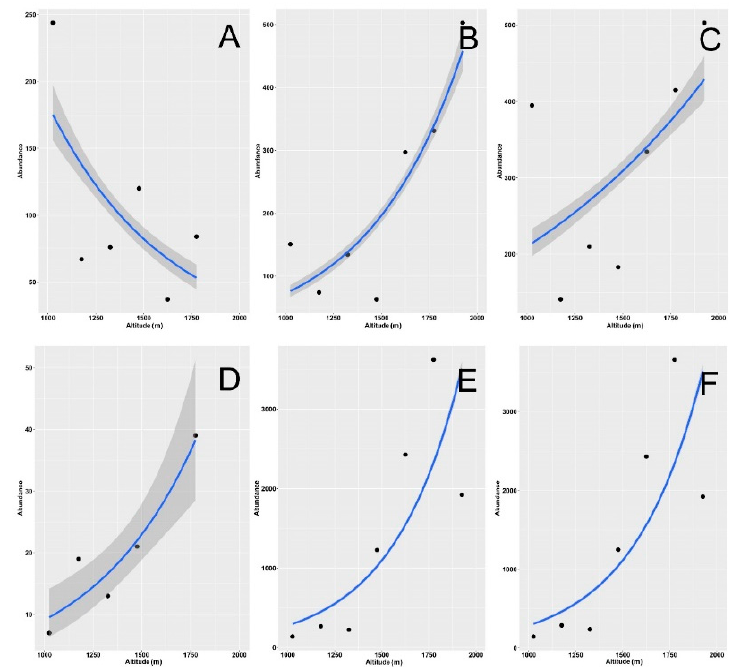
Figure 7. Relationship between dung beetle species abundance and altitude along an elevational gradient in central Italy. Curves were constructed separately for aphodiids ( A – C ) and scarabaeids ( D – F ) using standardized abundance values for the two habitats separately (woodlands: A , D and grasslands: B , E ) and merged ( C , F ). General linear models were used for fitting. Dashed areas are 95% confidence intervals. Confidence intervals in panels E and F are not distinguishable because of their narrowness. Table 4. Results of generalized linear models for the relationships between diversity ( A – C ) and abundance ( D ) of scara- baeid dung beetles and altitude along an elevational gradient in central Italy. Diversity (expressed as species richness, Shannon diversity and Simpson diversity) was calculated using empirical ( A ), rarefied/interpolated ( B ), and asymptotic ( C ) values. Analyses were conducted for the two habitats (woodlands and grasslands), both separately and merged. SE = standard error, P = probability, R 2 = Kullback–Leibler-divergence-based R 2 . Woodlands Grasslands Habitats Merged Estimate SE p R 2 Estimate SE p R 2 Estimate SE p R 2